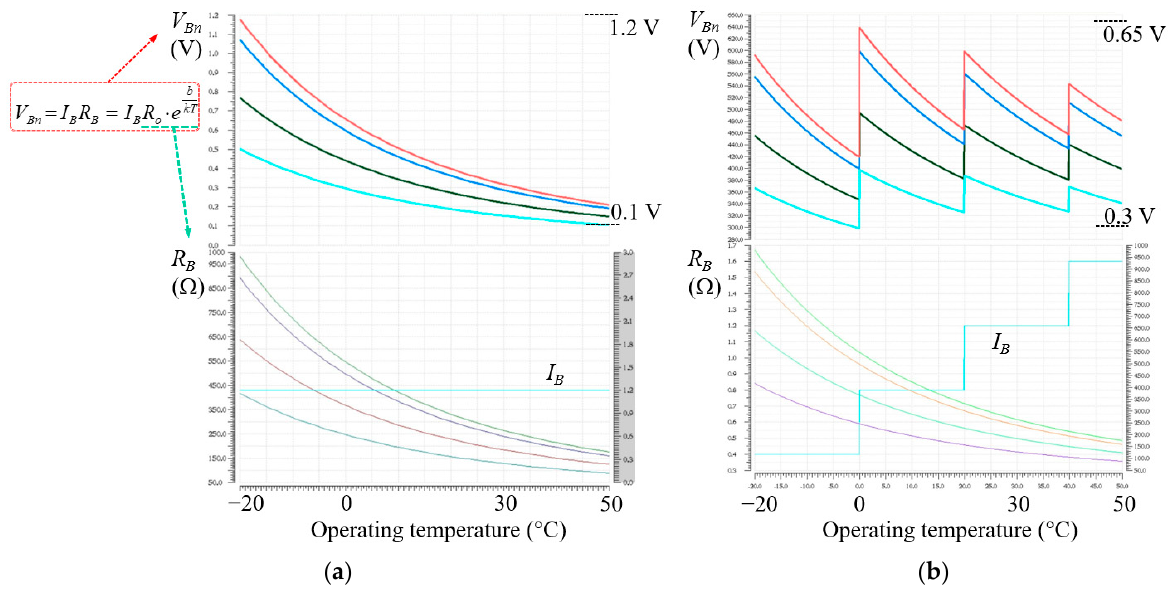
Figure 7. Variations and changes in R B and V Bn according to operating temperature: ( a ) When I B is independent of operating temperature; ( b ) when I B varies according to temperature section.